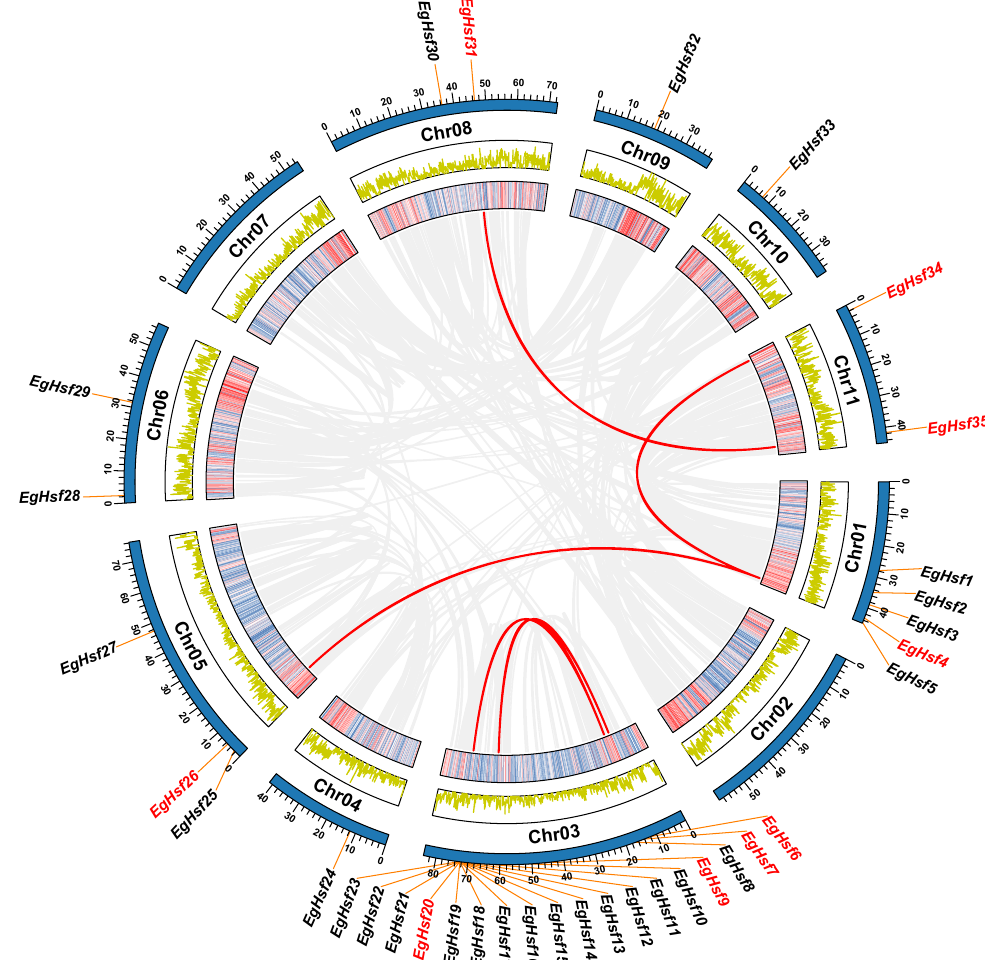
Figure 2. Chromosomal distribution and inter-chromosomal relationship of EgHsf genes. The two rings in the middle represent the gene density per chromosome, and the grey line represents the collinear block in the genome, while the red line represents the repeated EgHsf gene pair. EgHsf genes marked in red have collinearity, while EgHsf genes marked in black lack collinearity. TBtools was used for data